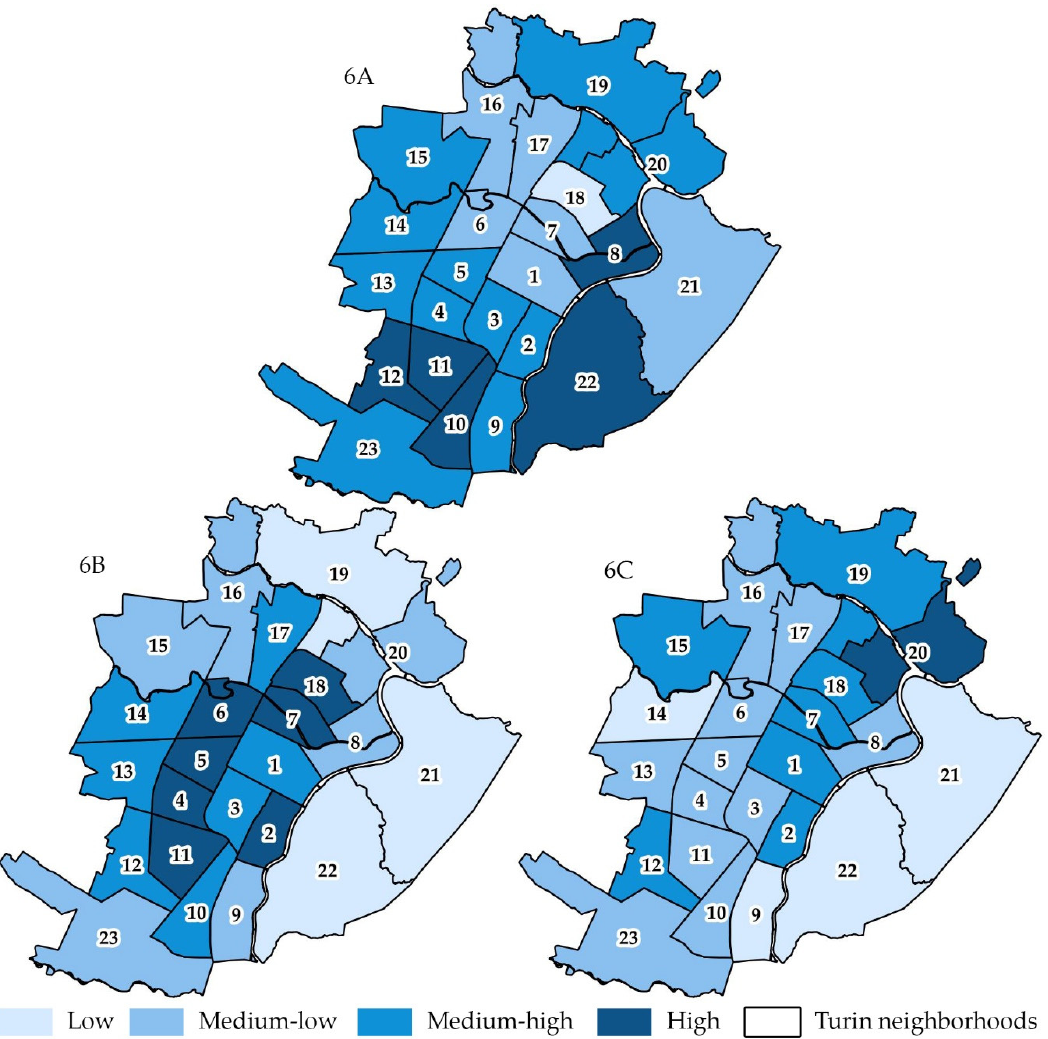
Figure 6. Socio-demographic characteristics of the neighborhoods’ ( A ) Aging index; ( B ) Housing density; ( C ) Economically assisted citizens.